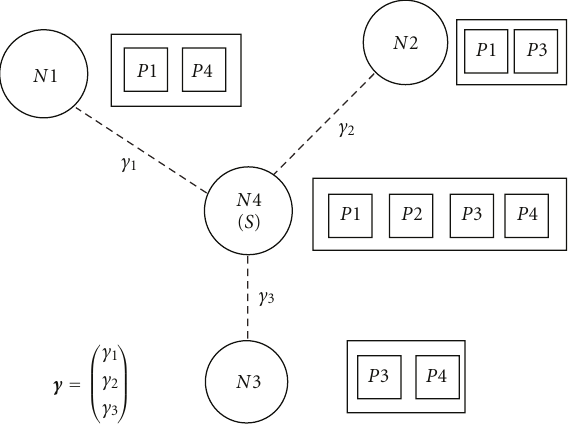
Figure 2: Network group formation. N 4 is going to access the channel. Node N 4 knows which packets are stored in its neighbors’ bu ff ers. Based on this knowledge it must choose which packets to XOR together in order to maximize the number of packets decoded in the transmission slot. A possible choice is, for example, P 1 + P 2 which allows nodes N 1 and N 2 to decode, but not N 3. A better choice is to encode P 1 + P 3 + P 4, so that 3 packets can be decoded in a single transmission. The di ff erence in SNR for the three sinks ( γ 1 , γ 2 , and γ 3 ) can lead to high packet loss probability on some of the links if a single channel rate is used for all the sinks. γ is the vector of